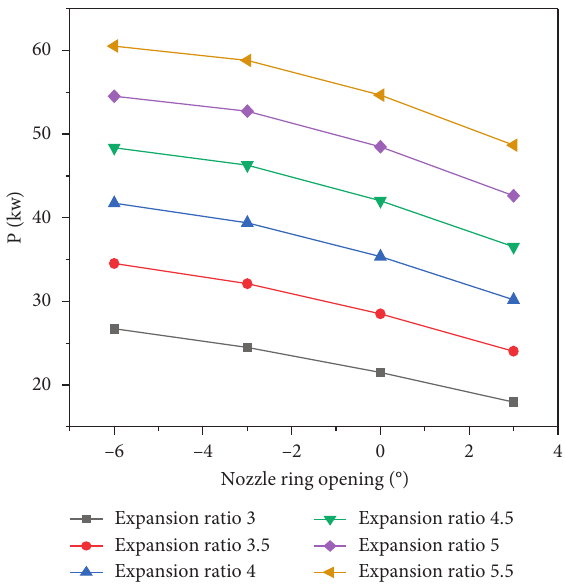
Figure 38: Relationship between opening and load.